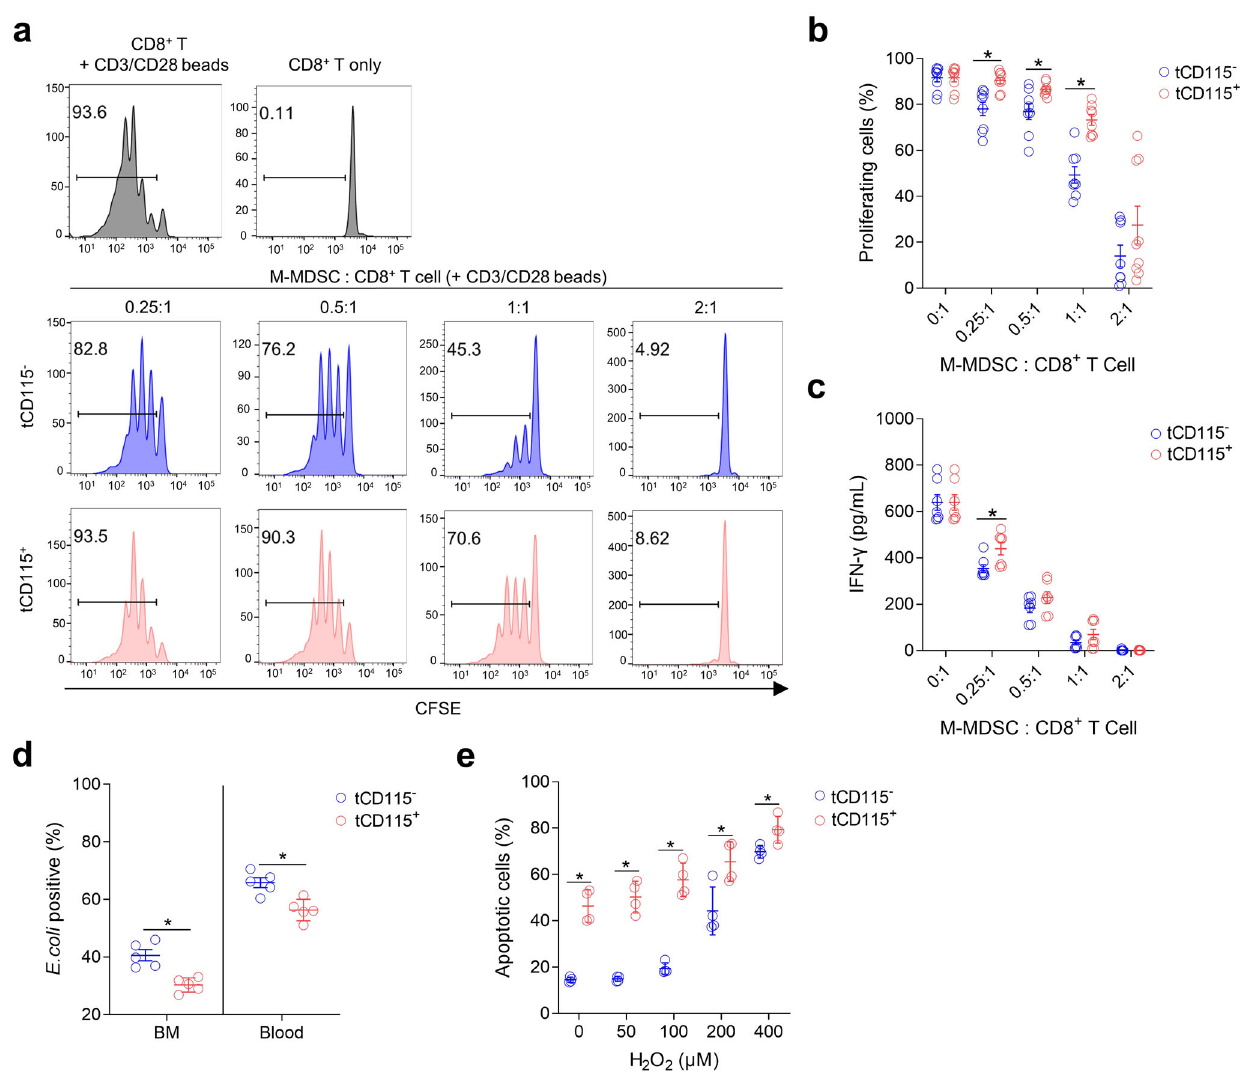
Fig. 2 CD115 − M-MDSCs have distinct phenotypes from CD115 + M-MDSCs. a – c Resting CD8 + T cells were activated with anti-CD3/CD28 beads in the presence of indicated ratios of sorted CD115 − or CD115 + M-MDSCs isolated from BM of EL4 TB mice. Suppression of CD8 + T cell proliferation was assessed 3 days after co-culture. a Representative FACS histogram. b Ratios of proliferating CD8 + T cells ( n = 8 – 9, data are pooled from three independent experiments). c IFN- γ levels in culture supernatant ( n = 8, data are pooled from three independent experiments). d BM and blood cells from EL4 TB mice ( n = 5 each) were incubated with FITC-labeled E. coli and the ratios of FITC-positive CD115 − and CD115 + M-MDSCs were assessed by FACS. e Total BM cells were harvested from EL4 TB mice ( n = 4) and treated with indicated concentrations of H 2 O 2 for 2 h to induce apoptosis. Annexin-V single positive and Annexin-V/7-AAD double-positive cells were assessed from CD115 − and CD115 + M-MDSCs. Data are pooled from two independent experiments. Multiple unpaired Student ’ s t test: * p < 0.05. Data are mean ±